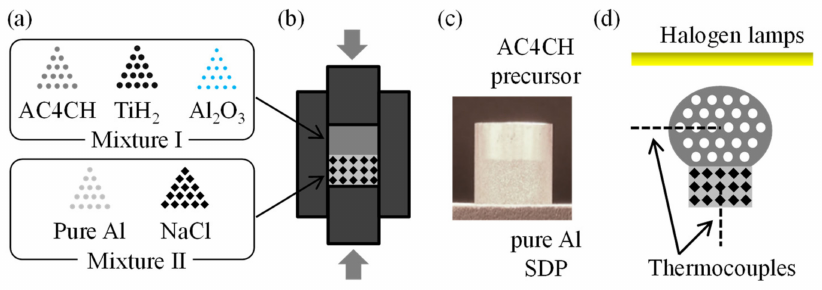
Figure 1. Fabrication of two-layered (AC4CH/pAl) Al foam. ( a ) Base powders. ( b ) Sintering. ( c ) As- sintered sample consisting of an upper precursor layer and lower sintering and dissolution (SDP) layer. ( d ) Foaming.